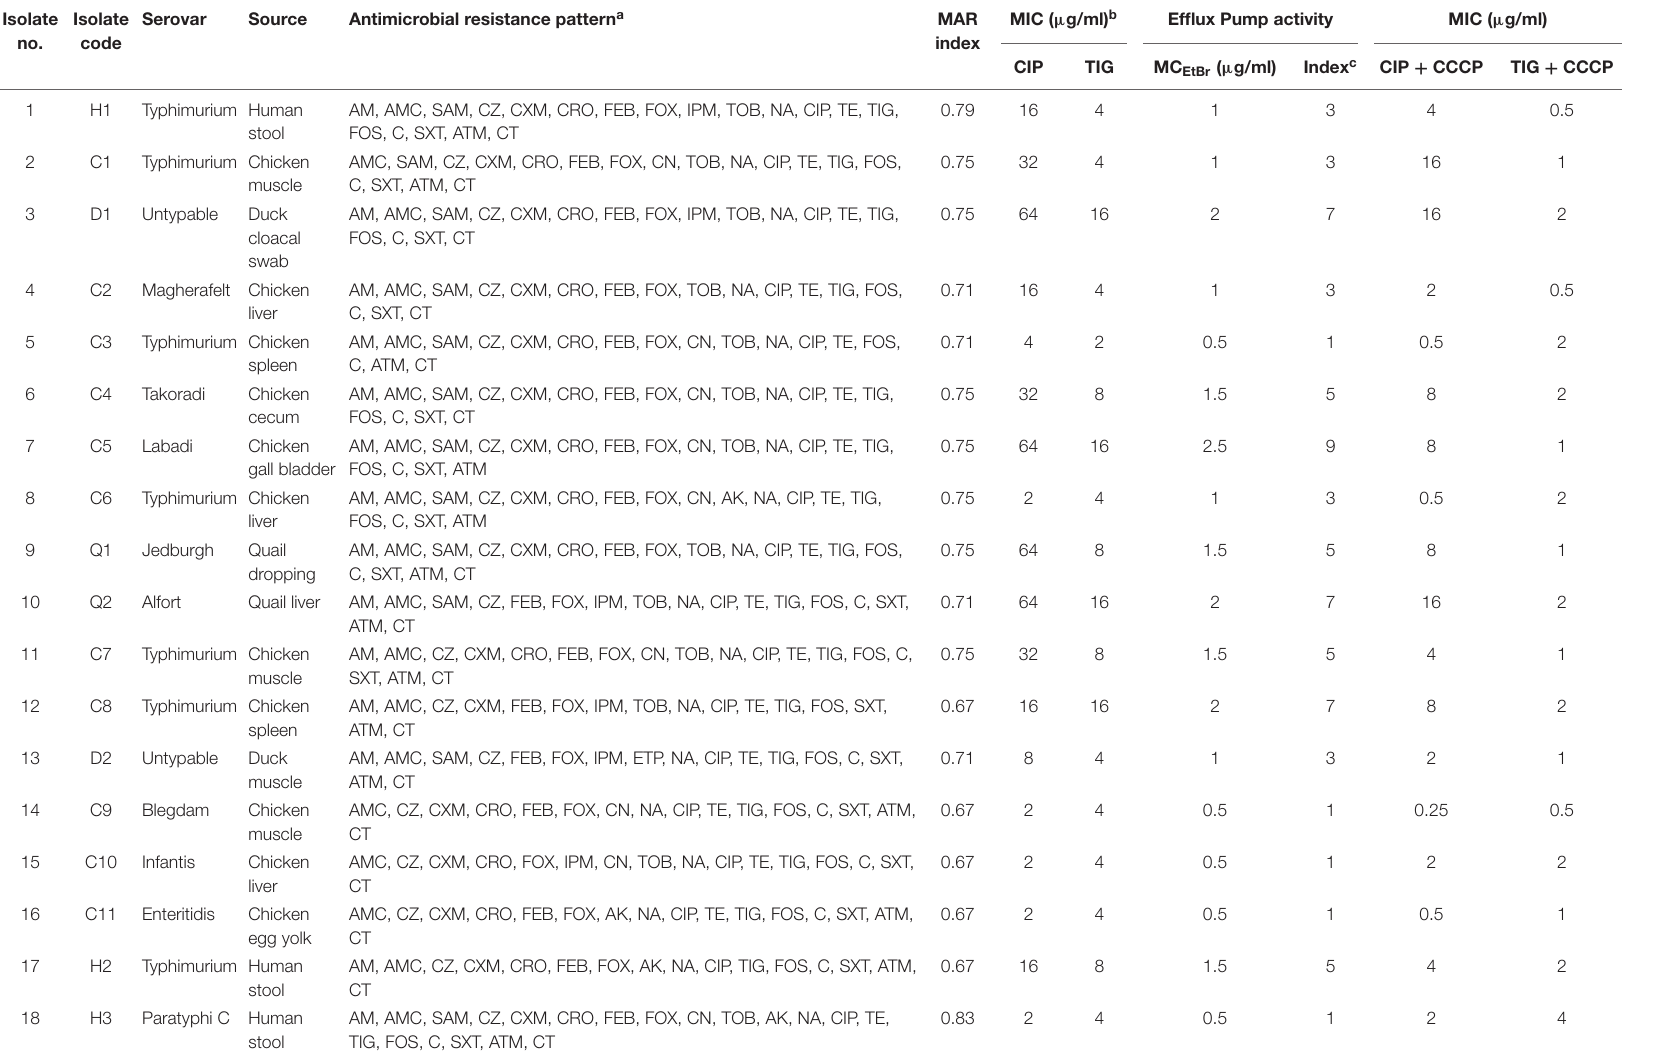
TABLE 2 | Phenotypic characterization of XDR Salmonella isolates recovered from poultry and human origins. Isolate